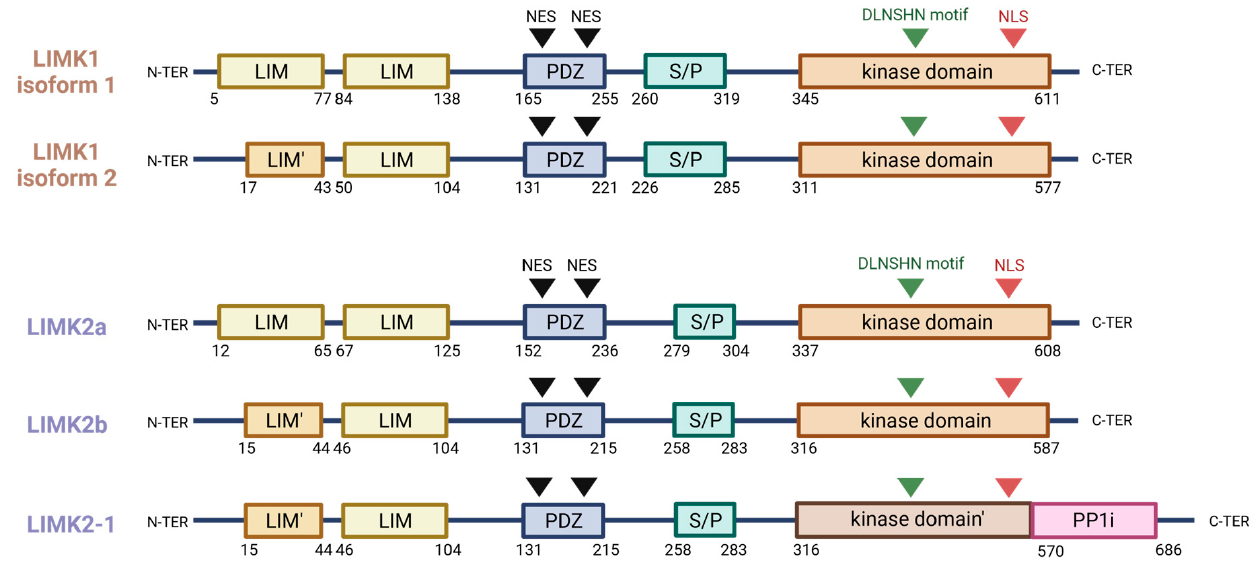
Figure 1. Schematic structures of human LIM kinases, LIMK1, and LIMK2, and their isoforms. Nuclear export signals (NES) are shown with a black arrowhead, DLNSHN motif is shown with a green arrowhead and nuclear localisation signal (NLS) is shown with a red arrowhead, ‘ stands for truncated domains.